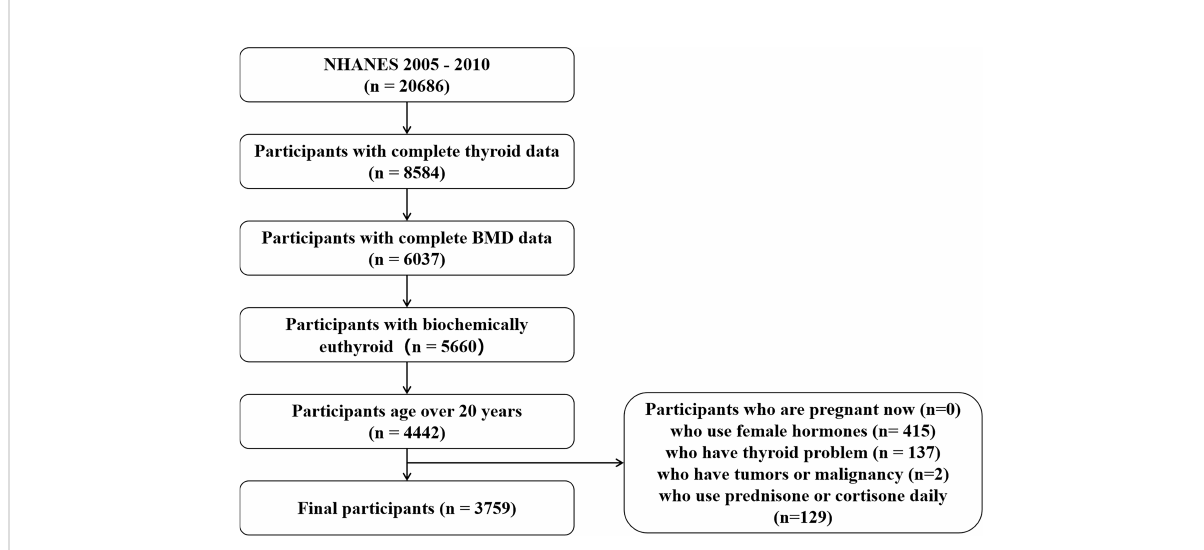
FIGURE 1 Flow chart of participant selection. NHANES, National Health and Nutrition Examination Survey; BMD, bone mineral